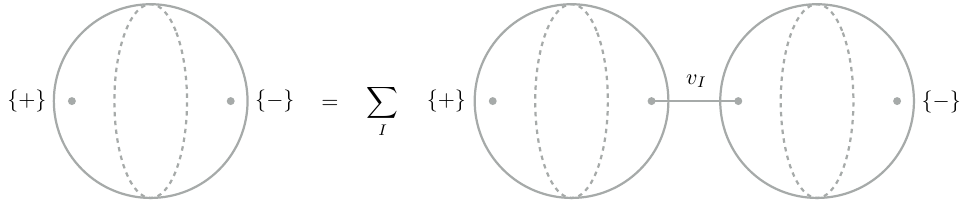
Figure 9. The (cid:10)-deformed A -model partition function on a sphere can be decomposed as a sum over the vacua v I of products of vortex partition functions centered on